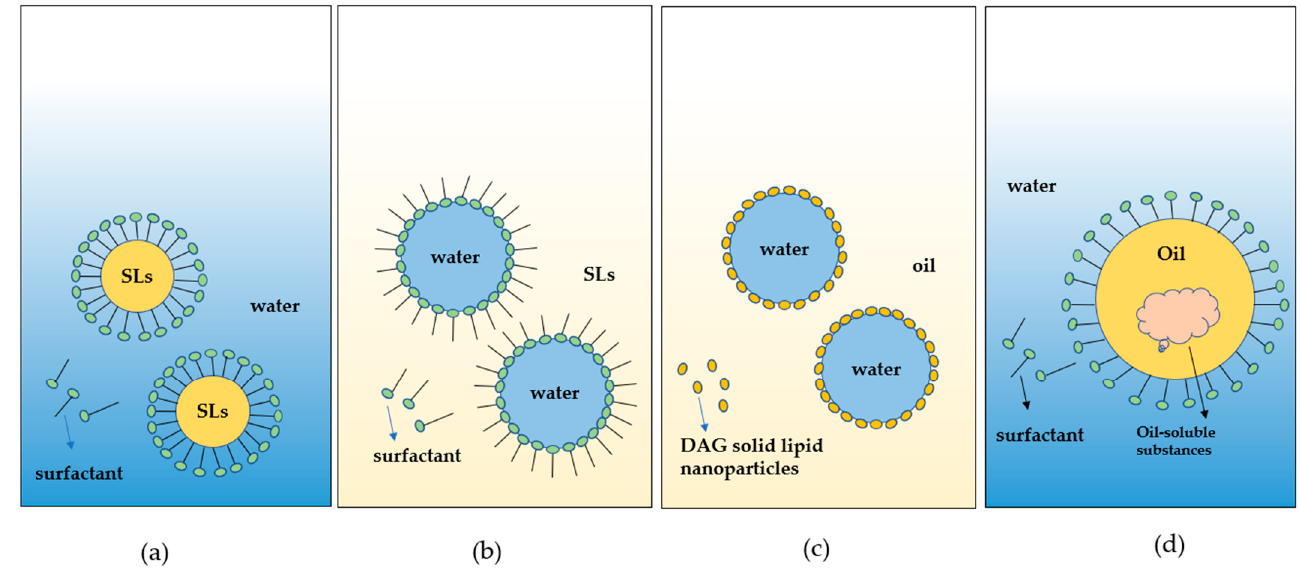
Figure 6. Schematic diagram SLs-based emulsions. ( a ) Oil-in-water emulsion; ( b ) water-in-oil emulsion; ( c ) Pickering emulsion formed from DAG-based nanoparticles as surfactants; ( d ) oil-in-water emulsion loaded with oil-soluble substances.